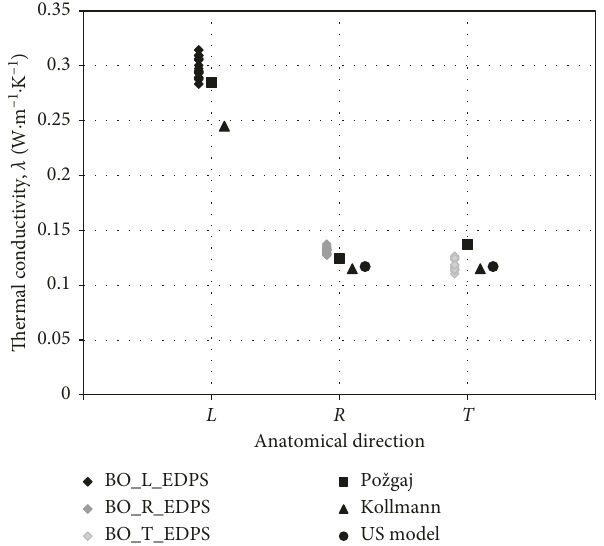
Figure 3: Thermal conductivity as a function of the anatomical direction in Scots pine (at the moisture content of